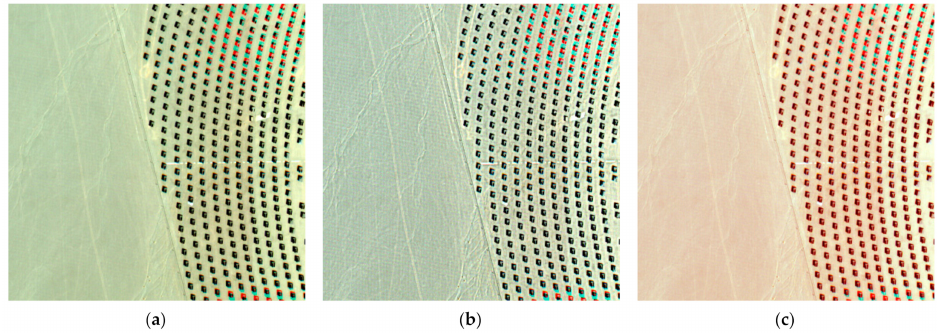
Figure 8. Images of Dunhuang on 27 July 2020. ( a ) Original image; ( b ) corrected image after Syn-AC; ( c ) corrected image after FLAASH. The retrieved AOD at 550 nm and retrieved CWV are 0.2 and 1.67 g/cm 2 , respectively.